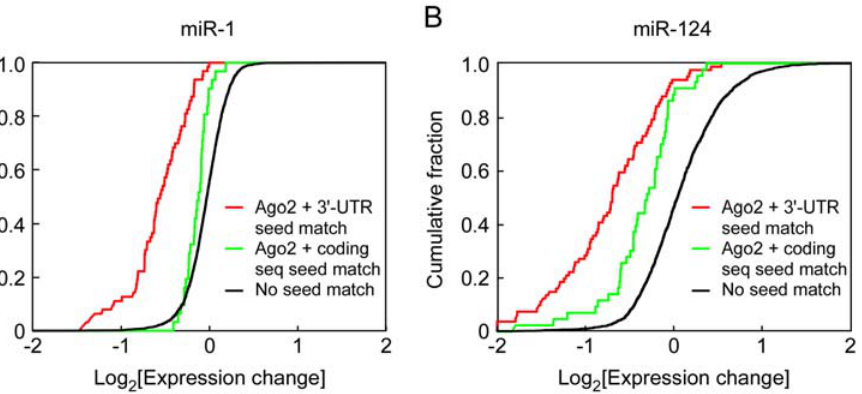
Figure 6. Comparison of expression changes of mRNAs containing seed matches in 3 9 -UTRs and coding sequences of miR-1 and miR-124 Ago2 IP targets. (A) Cumulative distribution of the change in mRNA levels following transfection with FLAG-Ago2 and miR-1 compared to FLAG-Ago2 alone. This analysis included Ago2 IP targets with 3 9 -UTR 7mer seed matches, but no coding sequence 6mer seed matches (21, red), Ago2 IP targets with coding sequence 7mer seed matches, but no 3 9 -UTR 6mer seed matches (10, green), and mRNAs that did not contain 3 9 -UTR or coding sequence 6mer seed matches (2893, black). Changes in mRNA levels of Ago2 IP targets with 3 9 -UTR 7mer seed matches were greater than those for Ago2 IP targets with coding sequence 7mer seed matches (P=0.0004), which were in turn greater than those for mRNAs without any 6mer seed matches in the 3 9 -UTR or coding sequence (P=0.006). (B) Same as in (A) except for mRNAs associated with FLAG-Ago2 upon transfection with miR- 124. There were 81 Ago2 IP targets with 3 9 -UTR 7mer seed matches but no 6mer coding sequence seed matches (red), 43 Ago2 IP targets with coding sequence 7mer seed matches but no 6mer 3 9 -UTR seed matches (green), and 1877 mRNAs with no 6mer seed matches in their 3 9 -UTR or coding sequence. Changes in mRNA levels of Ago2 IP targets with 3 9 -UTR 7mer seed matches were greater than the changes for Ago2 IP targets with coding sequence 7mer seed matches (P=0.0005), which in turn were greater than the changes for mRNAs without any 6mer seed matches in the 3 9 -UTR or coding sequence (P , 10 2 8